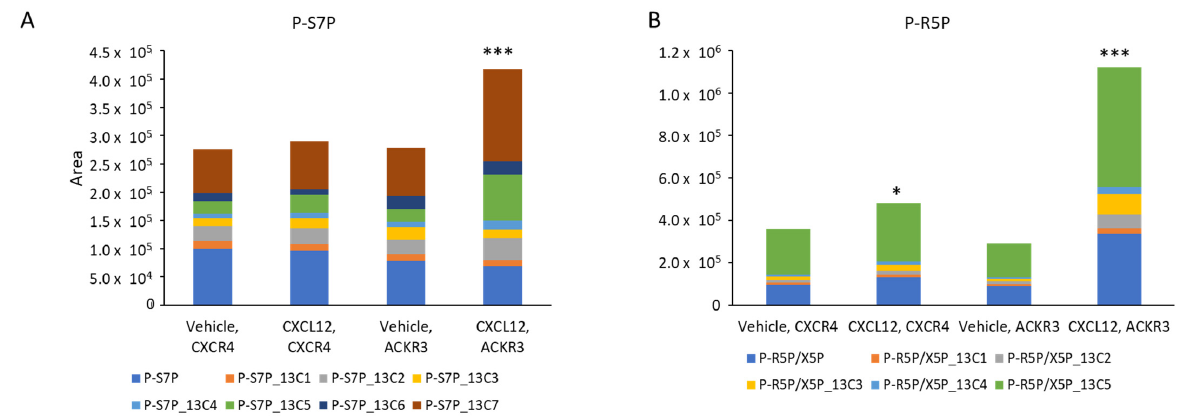
Figure 8. CXCL12 signaling through ACKR3 regulates metabolites in the oxidative and non ‐ oxidative pentose phosphate pathway. We incubated MDA ‐ MB ‐ 231 cells stably expressing CXCR4 or ACKR3 with 13 C 6 glucose and 300 ng/mL CXCL12 ‐α or vehicle for 15 min and then harvested cells for mass spectrometry, as in Figure 7. Graphs show selected metabolites in the pentose phosphate pathway regulated by CXCR4 and/or ACKR3 signaling. For each graph, different colors show the metabolite and number of incorporated 13 C molecules plotted as area from mass spectrometry analysis. Total height of each bar displays the sum of all detected molecules of the listed metabolite. ( A ) sedoheptulose ‐ 7 ‐ phosphate (non ‐ oxidative pentose phosphate pathway); and ( B ) ribulose ‐ 5 ‐ phosphate (oxidative pentose phosphate pathway). *, p < 0.05; ***, p < 0.005.